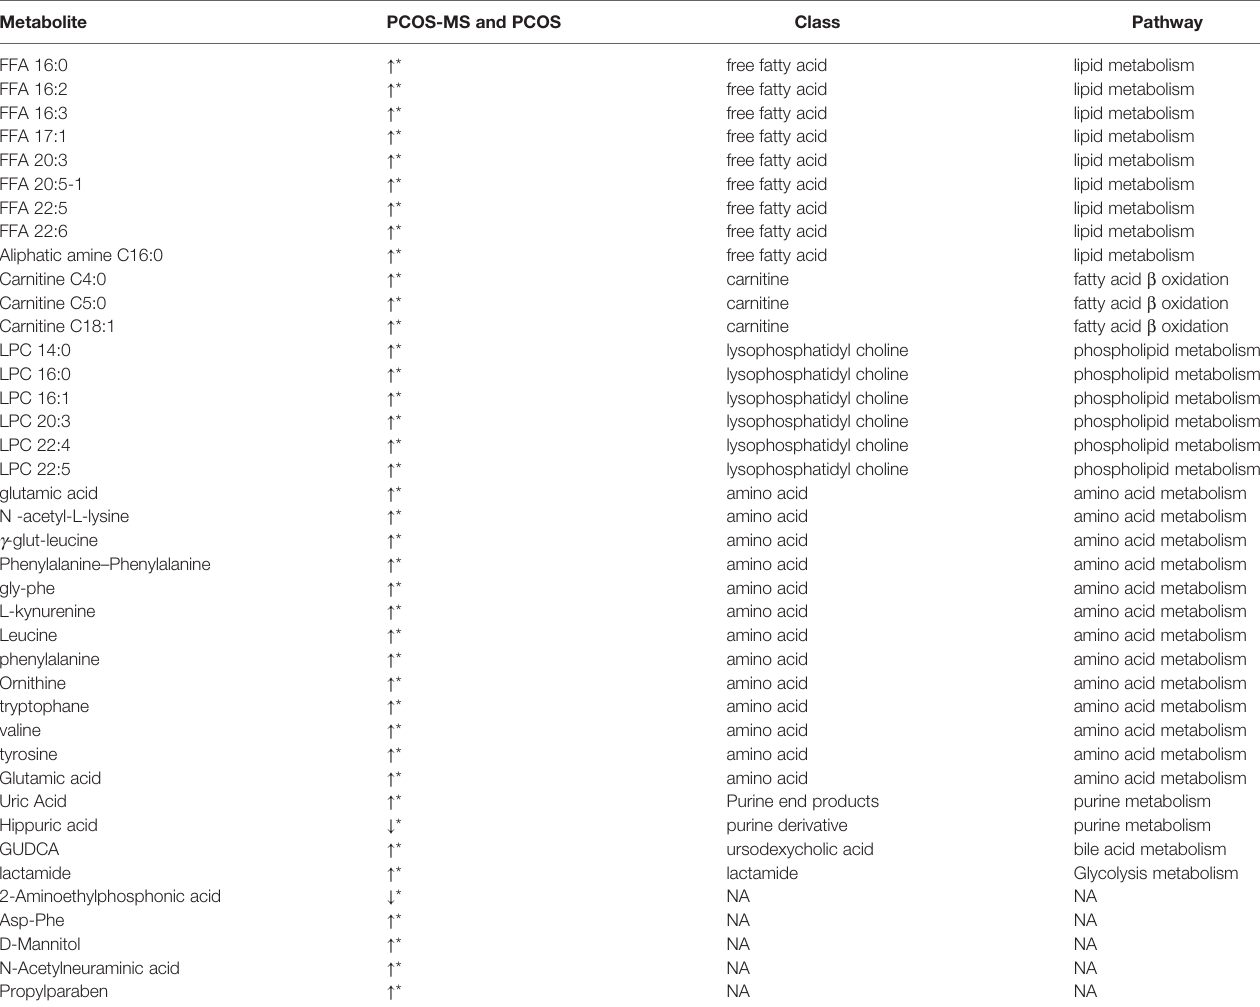
TABLE 2 | Differential metabolites between PCOS group and PCOS-MS group. Metabolite PCOS-MS and PCOS Class